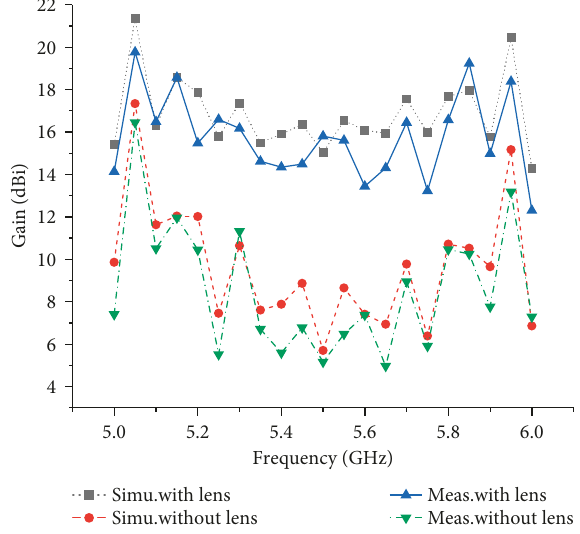
Figure 15: Gain comparison between the antenna without and with a dielectric lens.